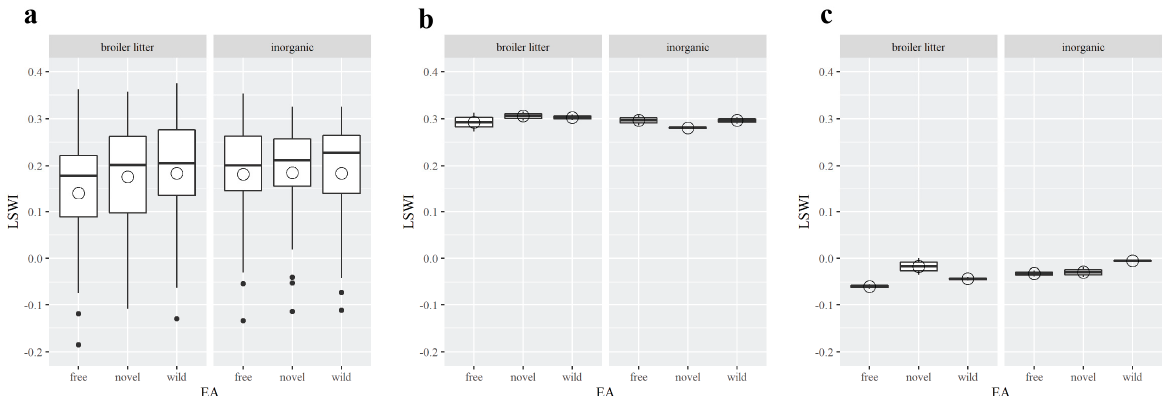
Figure 7. Box plots of mean land surface water index (LSWI) values during ( a ) normal (3 year), ( b ) wet (1 year), and ( c ) dry (1 year) years for each endophyte association (EA; free, novel, and wild) and fertilizer type (broiler litter or inorganic). The large circles represent the mean value for the respective paddocks. It is worth noting that inorganic wild and broiler litter free were significantly different ( p < 0.05) from other pairs of endophyte and fertilizer